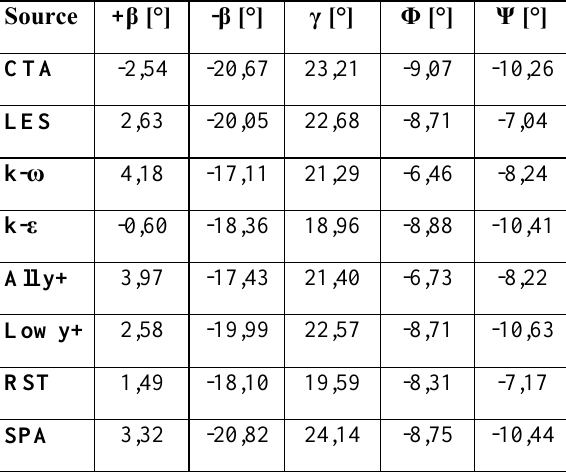
Table 2. The direction angles for the vertical plane [10]